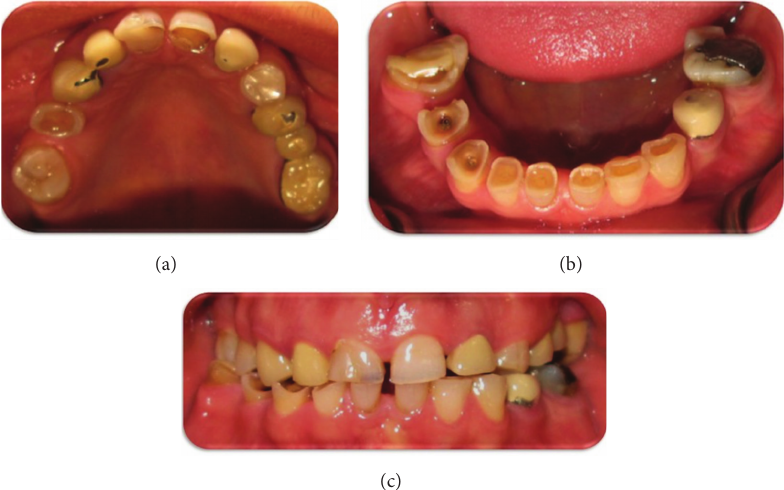
Figure 1: Pretreatment intraoral view.